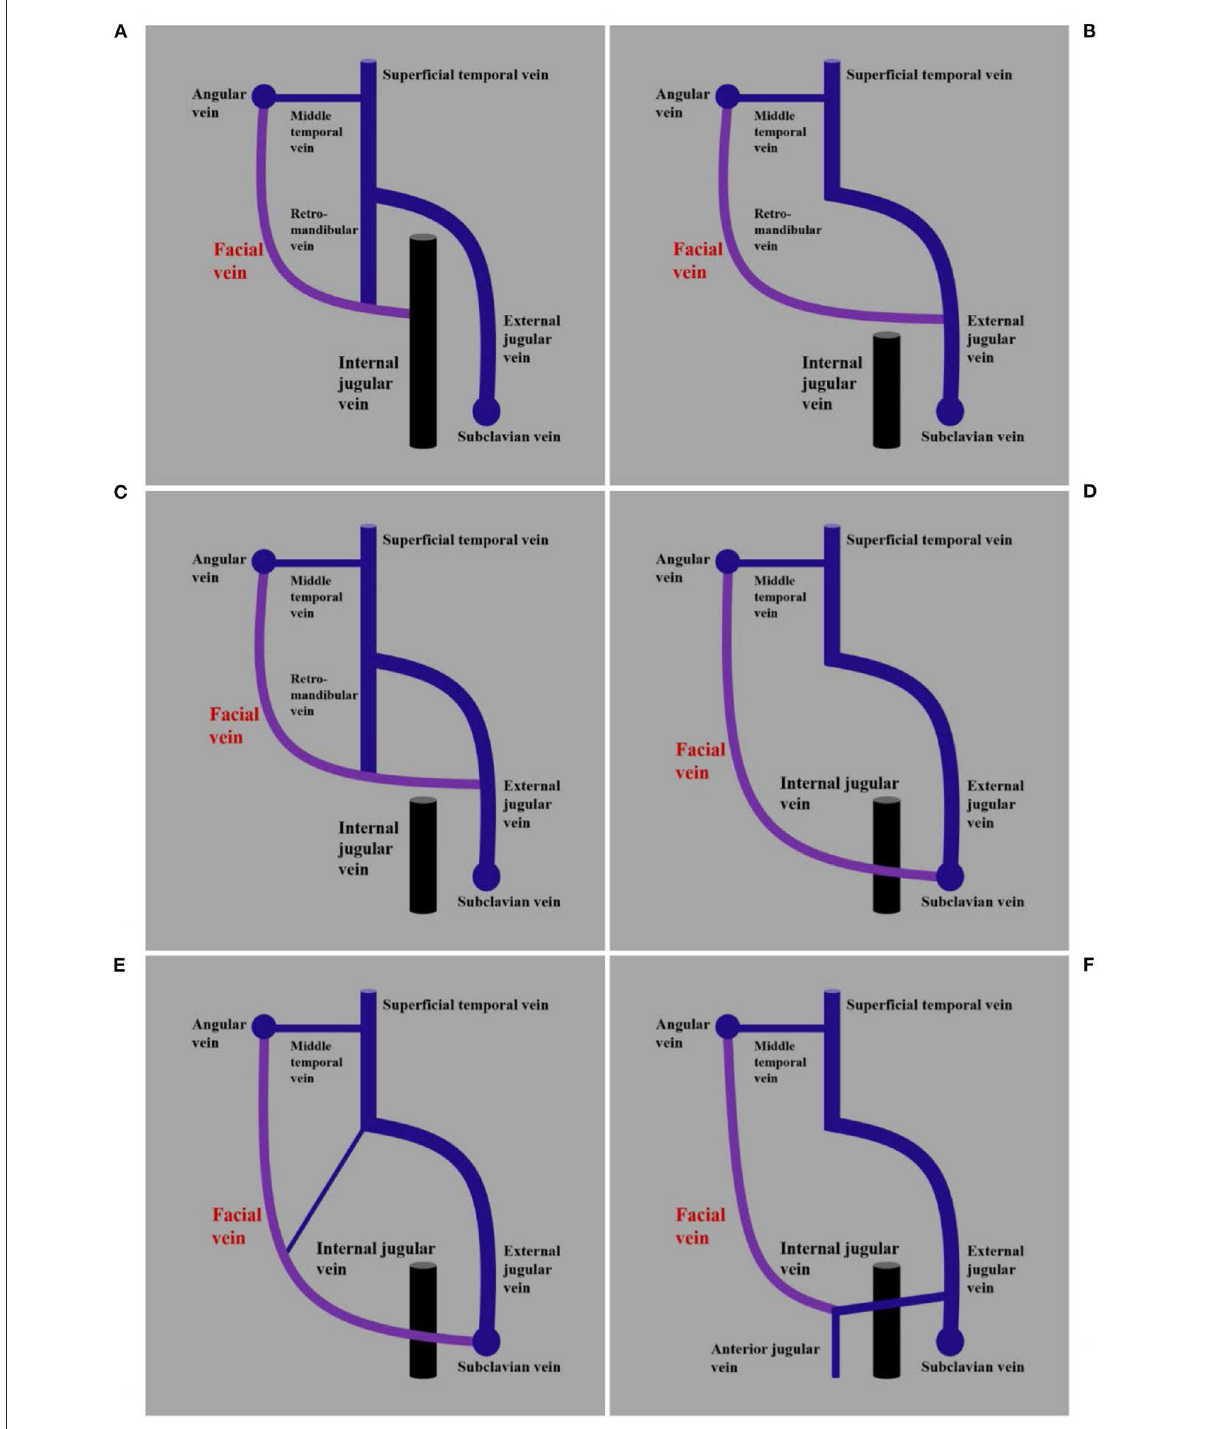
FIGURE4 Illustrations of normal anatomy and variation of the FV. (A) Imaging shows the FV together with the retromandibular vein into the IJV. (B) Imaging shows the FV without the connection of the retromandibular vein into the EJV. (C) Imaging shows the FV without the connection of the retromandibular vein into the EJV. (D) Imaging shows the FV without the connection of the retromandibular vein into the subclavian vein. (E) Imaging shows the FV with the connection of the retromandibular vein into the subclavian vein. (F) Imaging shows the FV with the connection of other veins into the anterior jugular vein. AJV, anterior jugular vein; EJV, external jugular vein; FV, facial vein; IJV, internal jugular vein; MTV, middle temporal